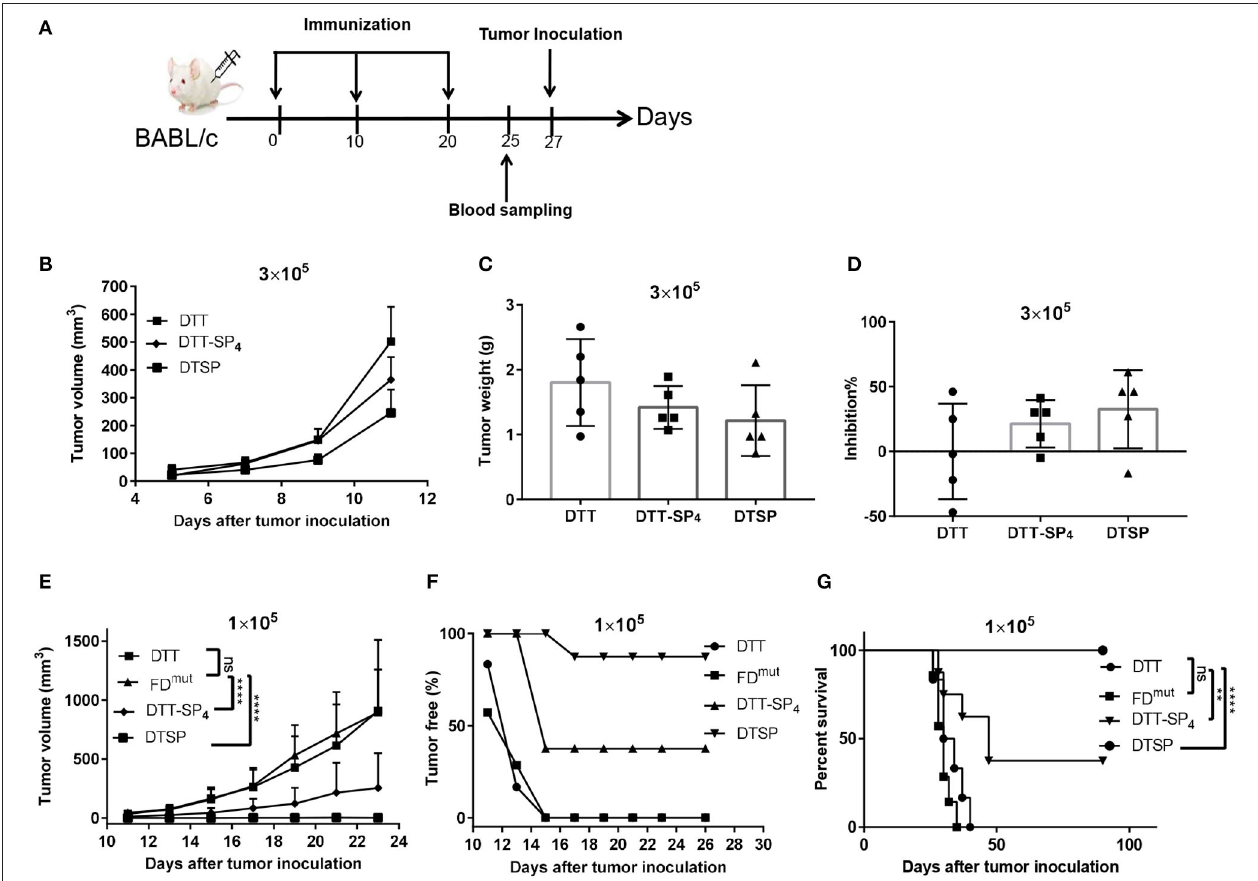
FIGURE 3 | Protective effect of DTT-SP 4 or DTSP against tumor development after receiving two different CT26 cell doses in the tumor model. (A) Flow chart of immunization and tumor inoculation. (B–G) Mice were immunized with Alum and CpG formulated DTSP, DTT-SP 4 , FD mut , or DTT, three times at 10-day intervals. Mice received two different doses of CT26 cells s.c. into the right flank 1 week after the third administration of the vaccine. (B–D) Female BALB/c mice ( n = 5–8) were inoculated with 3 × 10 5 CT26 cells/mouse. (B) Tumor volumes were determined in individual mice and calculated for each group. Data are means ± SD. Student’s t -test. Mice were sacrificed on day 23 after tumor challenge. Tumors weights were measured (C) and the tumor inhibition rates were evaluated (D) . (E–G) Immunized mice were challenged with CT26 cells (1 × 10 5 cells/mouse). (E) Tumor growths were monitored every 2–3 days after the tumors were palpable and were presented as tumor volume (mm 3 ). Data are means ± SD. ns, not significant, **** p < 0.0001, ns, not significant, Student’s t -test. (F) The proportion of tumor-free mice was plotted at different time points after tumor injection. (G) Percent survival was plotted by Kaplan–Meier method, and log-rank (Mantel–Cox) test was used to calculated the p -value. ** p < 0.01, **** p < 0.0001, ns, not